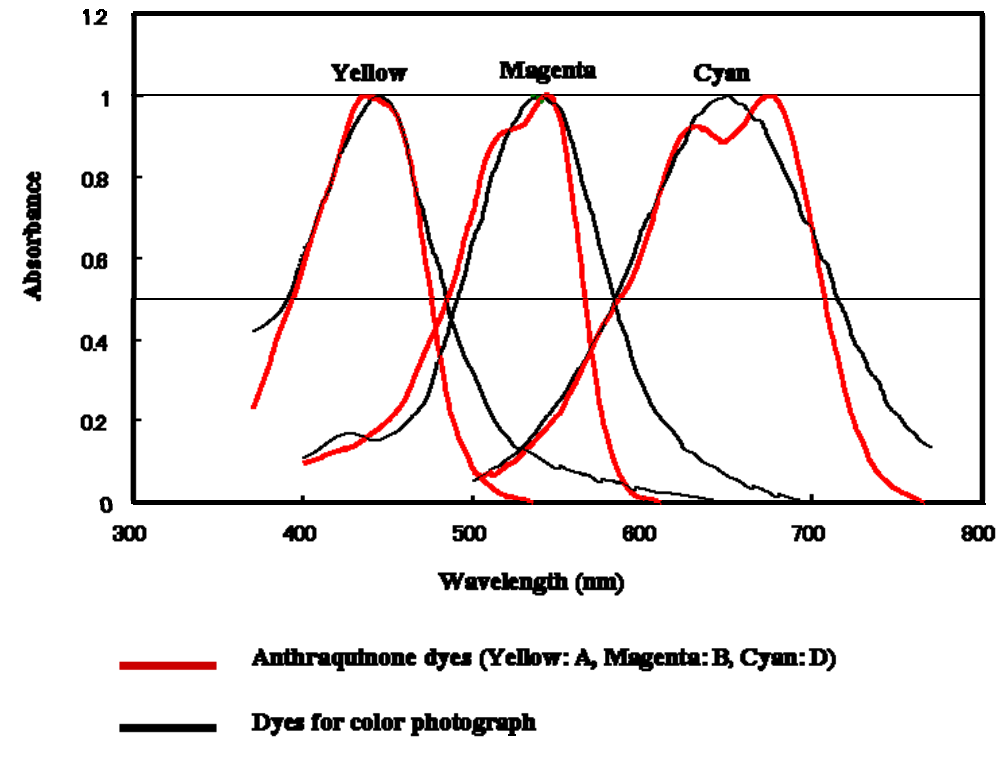
Figure 5. The comparison of absorption spectra of anthraquinone dyes for the three-layer GH-LCDs and photographic